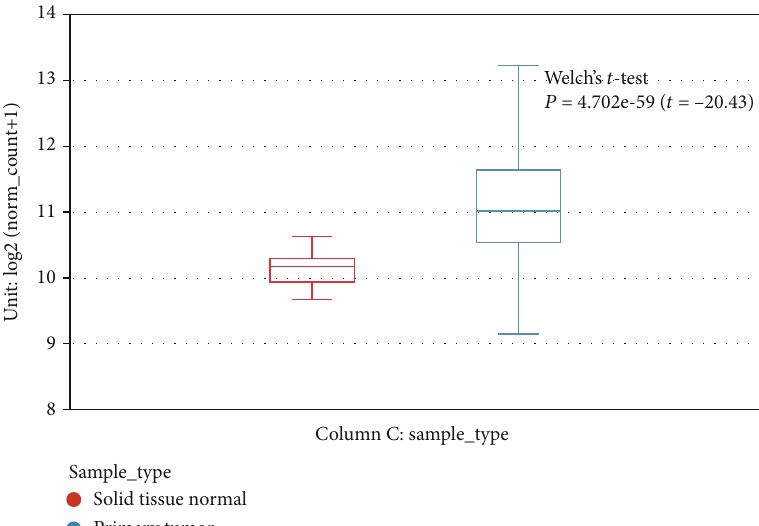
Figure 1: Bioinformatics analysis of FKBP4 expression in NSCLC: (a) expression analysis of FKBP4 in large cell lung cancer; (b) expression analysis of the FKBP4 gene in squamous cell lung cancer; (c) expression analysis of FKBP4 lung adenocarcinoma ( N = 640 , Welch ’ s t -test, P = 4 : 702 e − 59